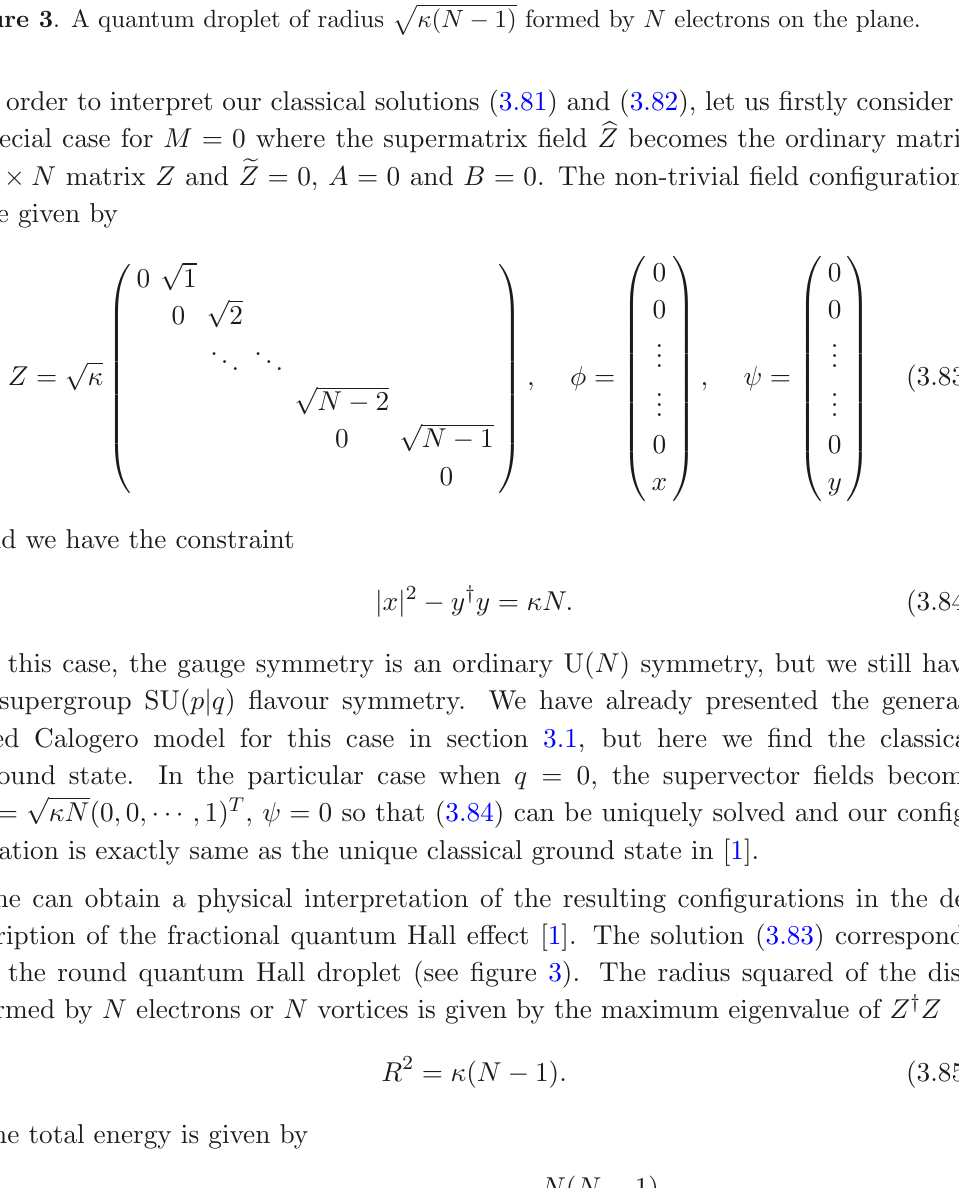
Figure 3 . A quantum droplet of radius